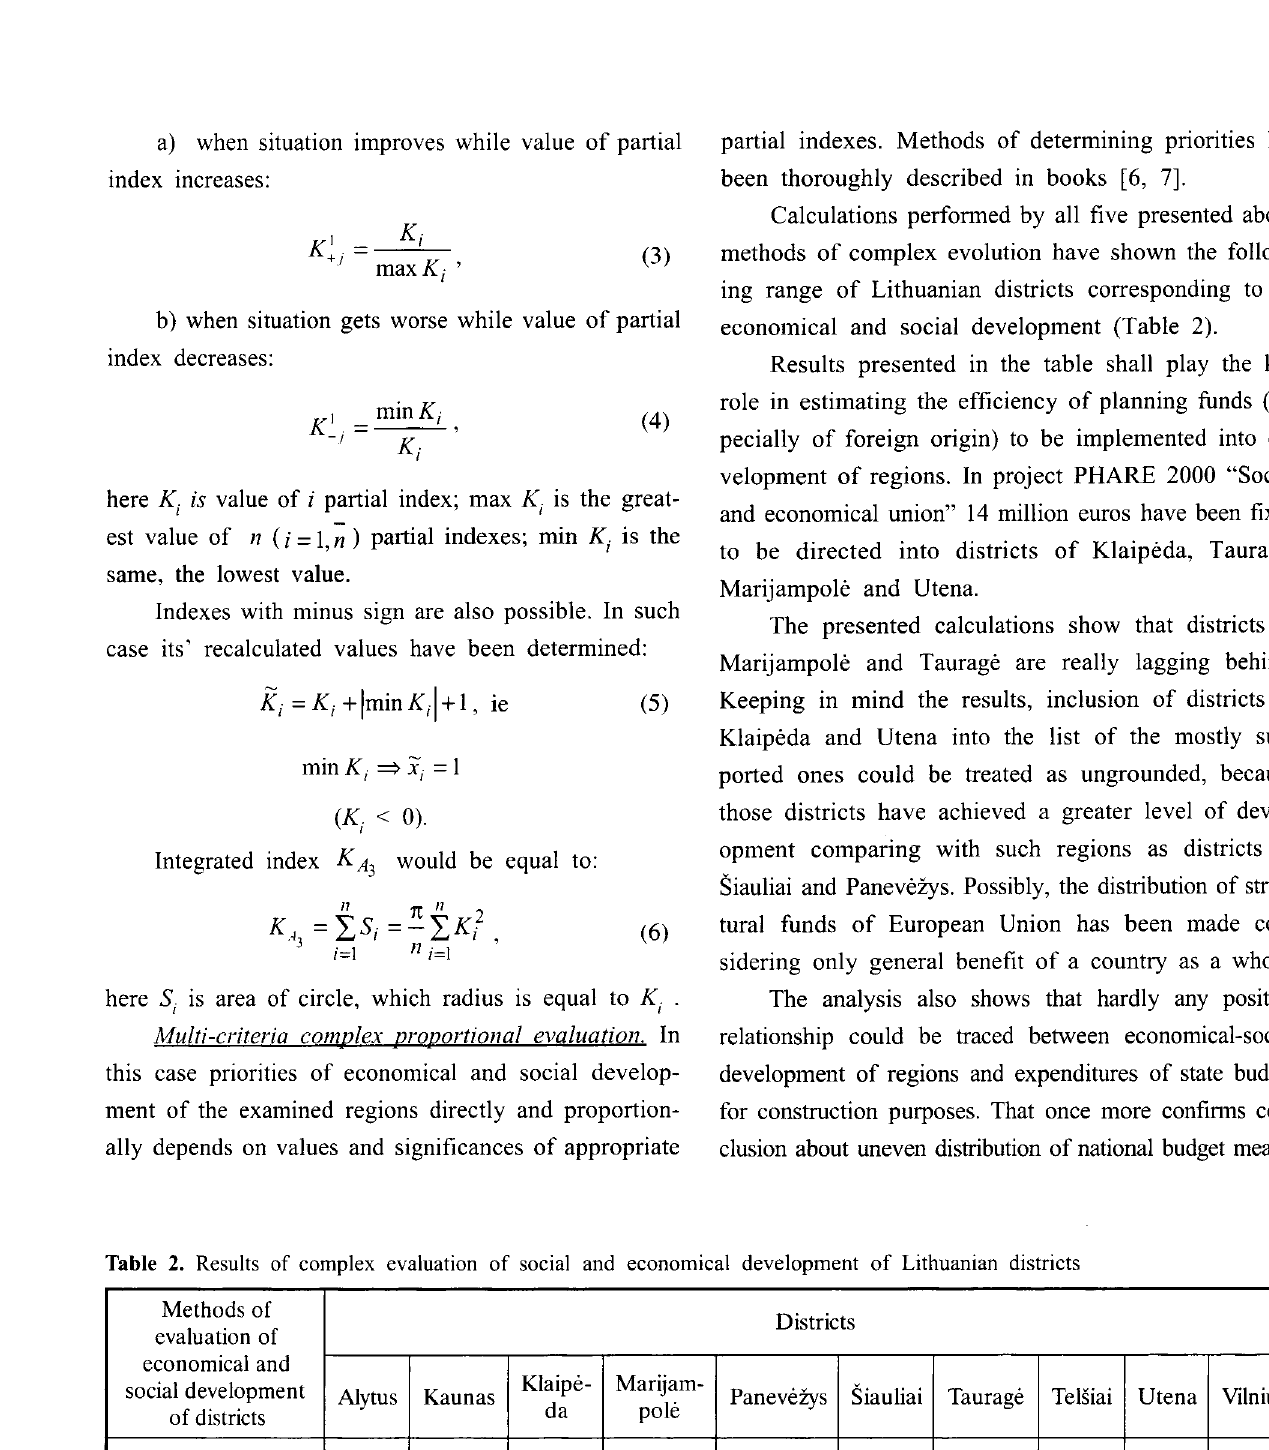
Table 2. Results of complex evaluation of social and economical development of Lithuanian districts Methods